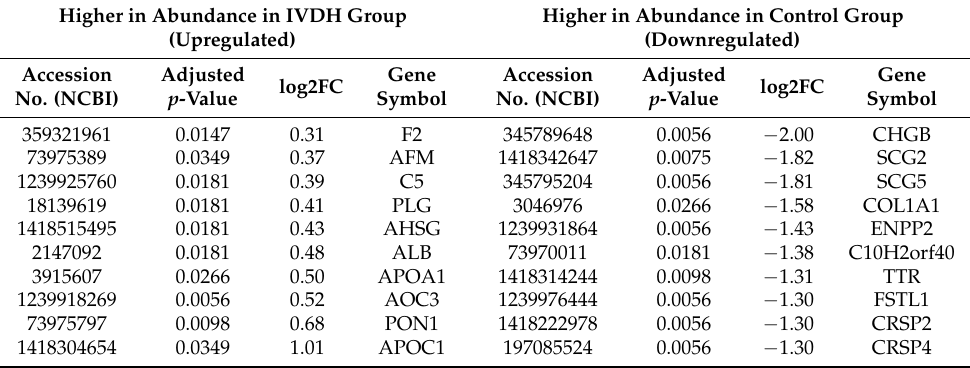
Table 1. The top 10 most significantly changed proteins in cerebrospinal fluid of dogs with interver- tebral disc herniation (IVDH) compared to healthy dogs. Complete list of all significantly changed proteins can be found in Supplementary File